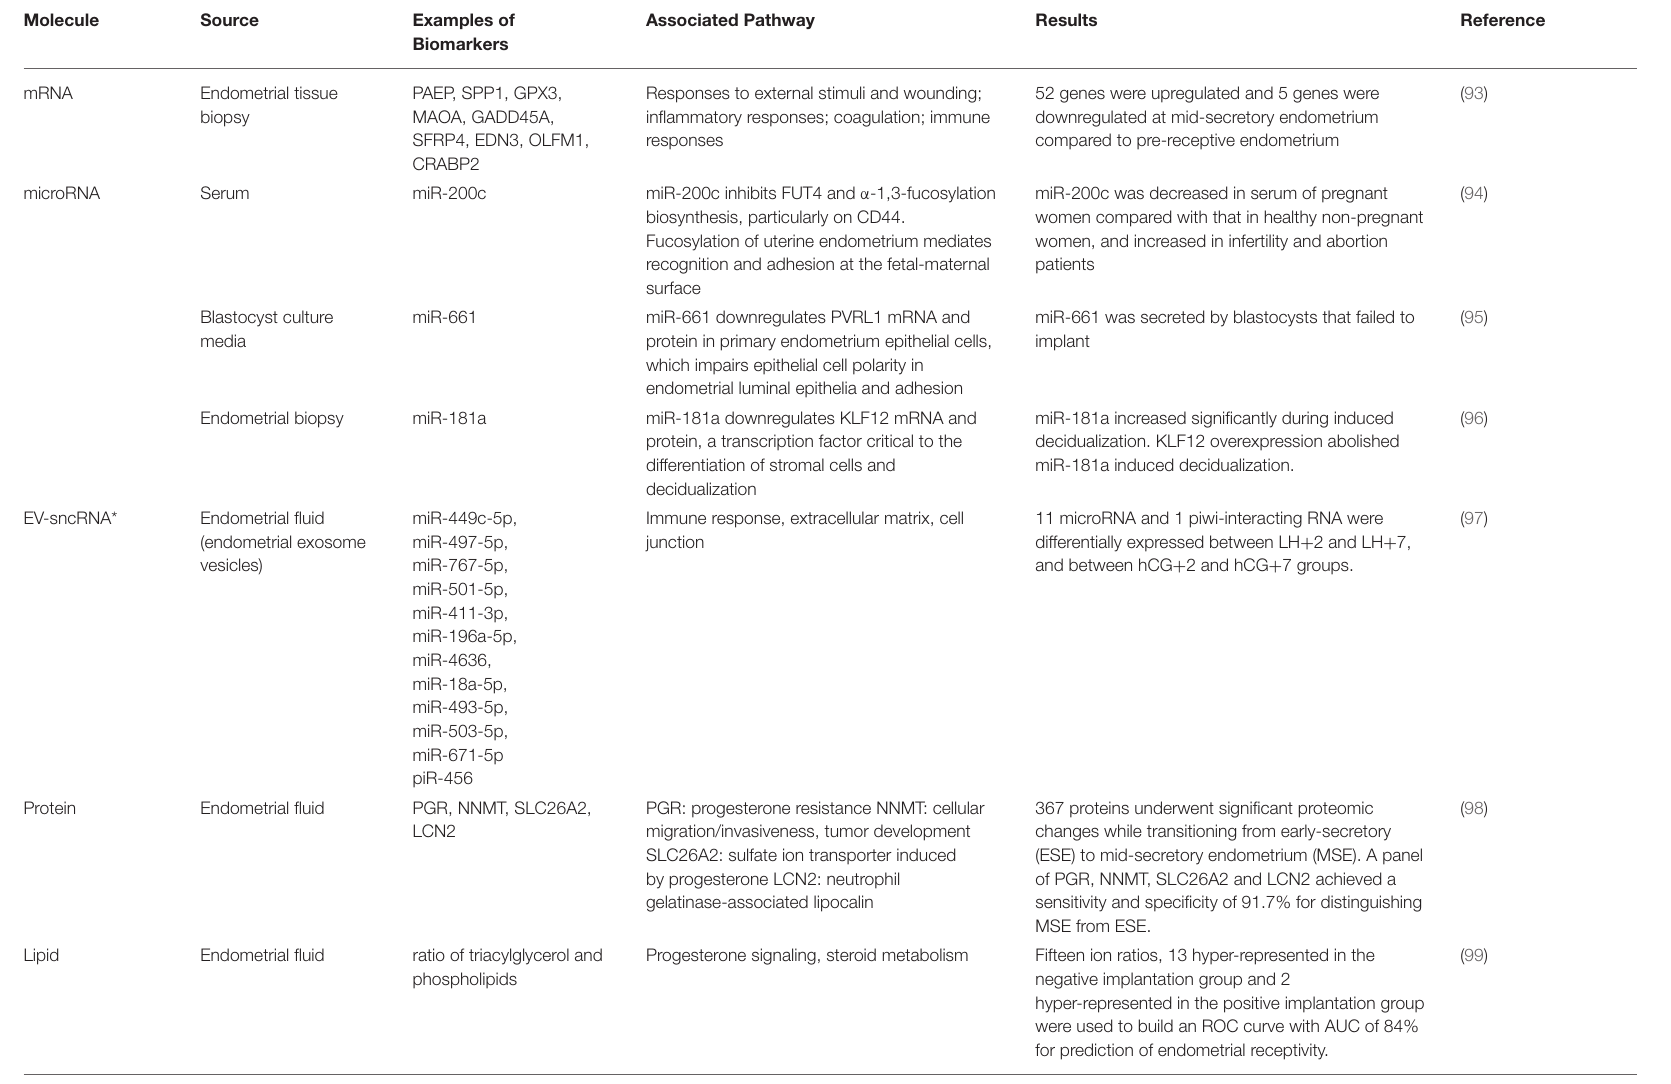
* extracellular vesicle derived small non-coding